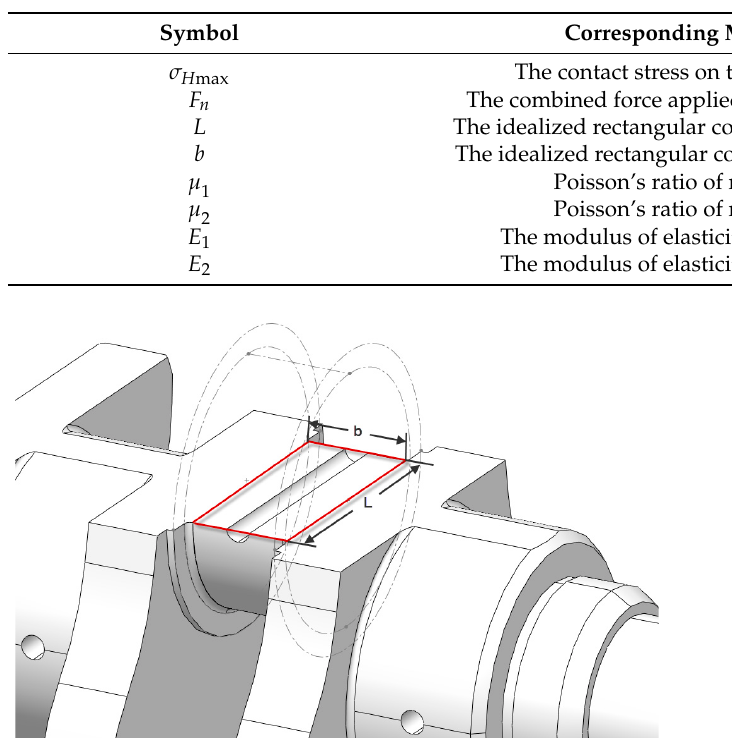
Figure 2. Location of Equation (1) b and L .